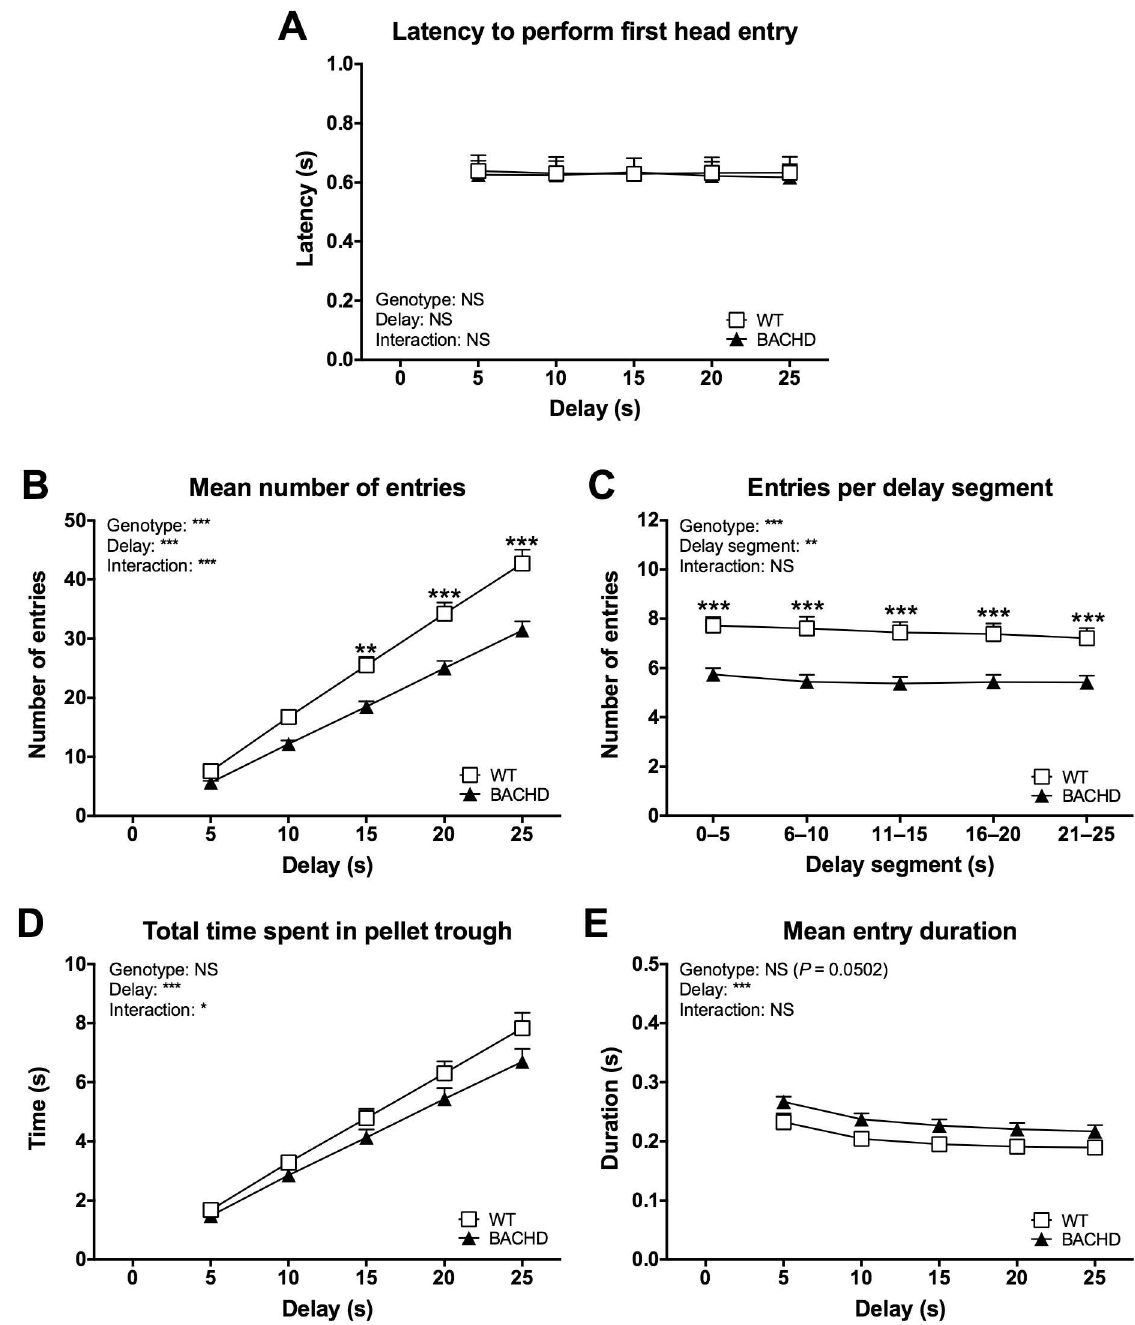
Fig 8. Head entry behavior during delays on the delayed non-matching to position protocol. The graphs show several aspects of head entries made into the pellet trough duringdelay steps of the delayednon-matching to positiontest. Curves were created based on the overall performance on all test ages, as no consistent changewith age was found for the parameters. (C) concernsthe 25-second delay step. Graphs indicategroup mean plus standard error. Results from two-way repeated measures ANOVA are shown insidethe graphs. Results from post-hoc analysisare indicatedin case significantgenotypedifferences were found. * ( P < 0.05) ** ( P < 0.01) *** ( P < 0.001).